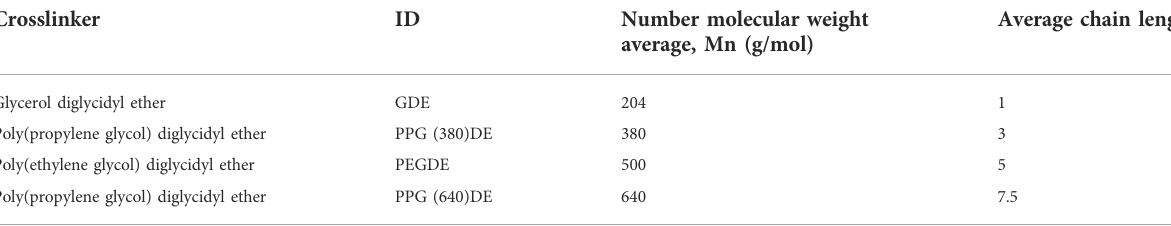
TABLE 1 Each diglycidyl ether investigated to crosslink carboxymethyl cellulose.